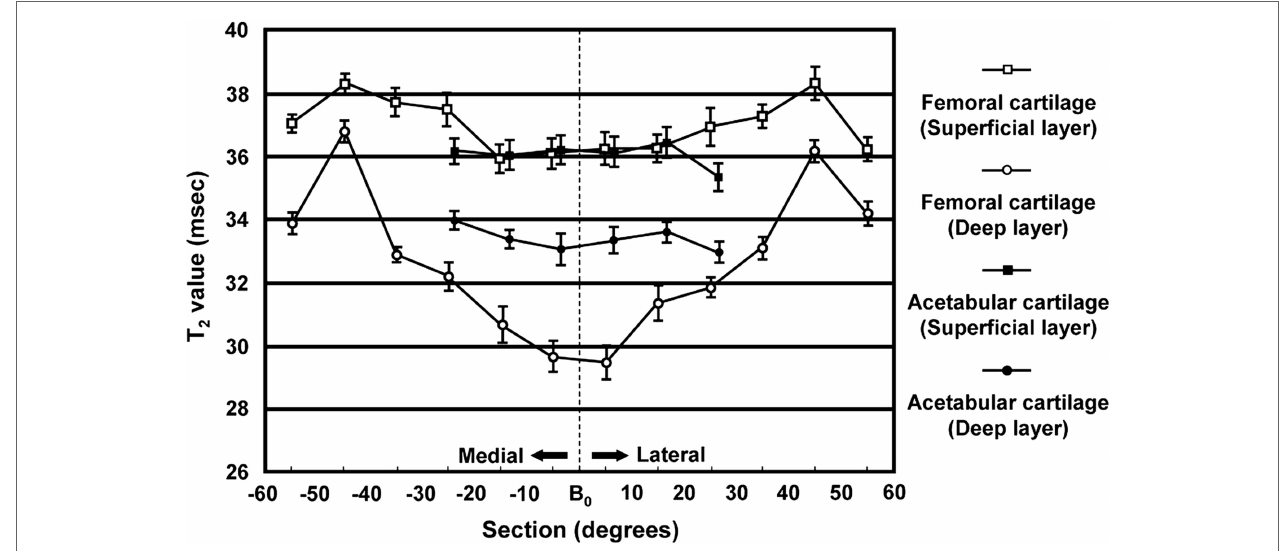
probably because of factors including cartilage matrix composition and magic angle effect that need to be considered when interpreting and evaluating T2 values in hip joint cartilage. Figure reprinted with permission